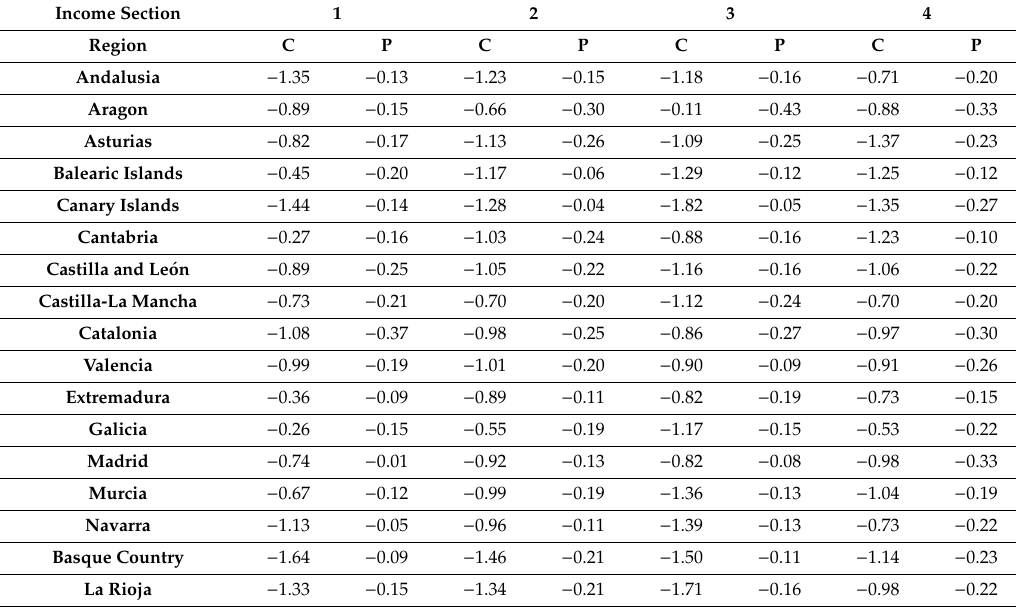
Table 6. Elasticities Obtained by Income Section and Region from Models (1) and (2)